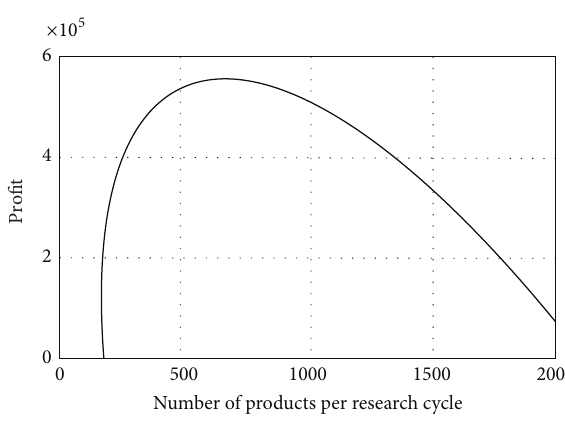
Figure 6: The dependence between the profit Pr 𝑜 and the number of items sold after which innovation is introduced (Matlab).